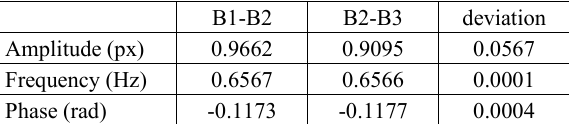
Table 4. Parameters of the jitter